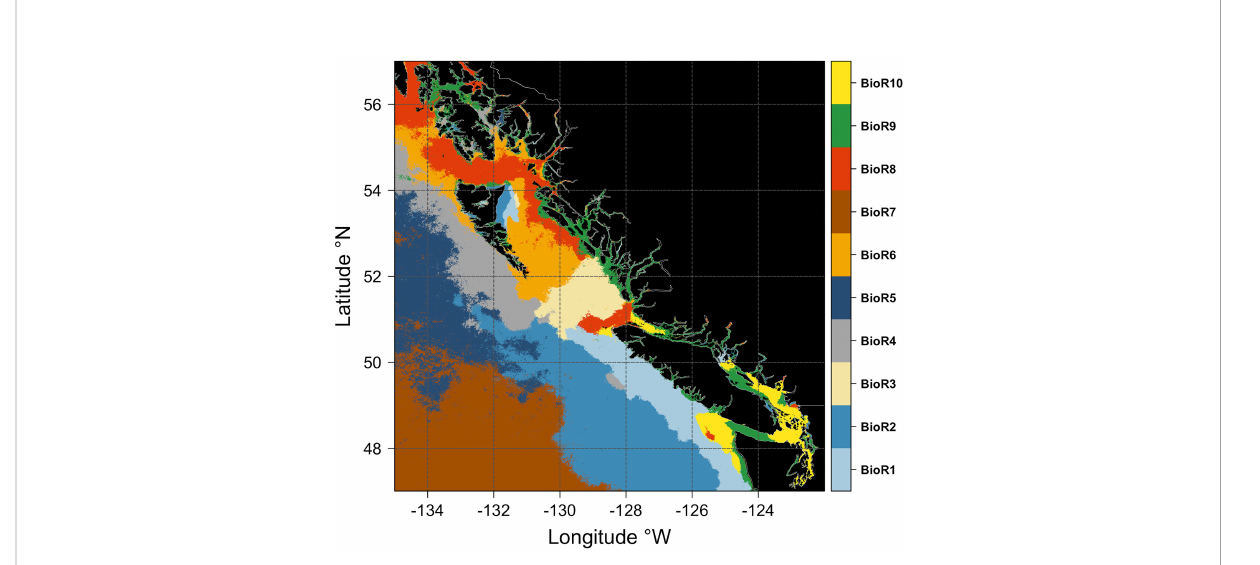
FIGURE 5 Maps showing the spatial distribution of the ten bioregions obtained from the two-step classi fi cation procedure (see Figure 3). Each bioregion is assigned a color (see the vertical bar on the left). Black areas denote the land.